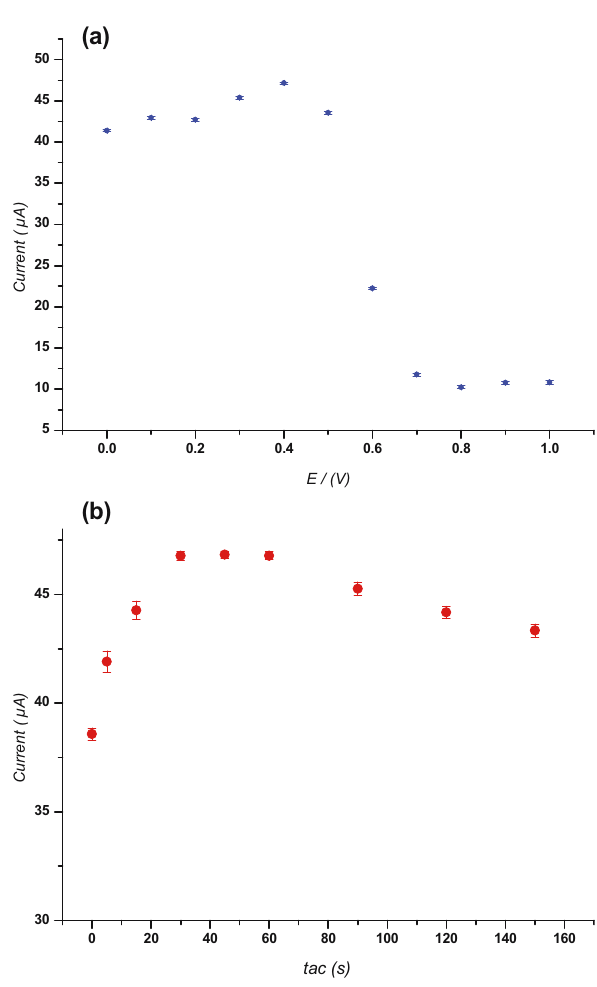
Figure 4: E ff ect of accumulation potential ( a ) and accumulation time ( b ) on peak currents of 1.0 × 10 − 4 M SUL using GO/ β - CD modi fi ed PGE in BRB pH 10.0 as a supporting